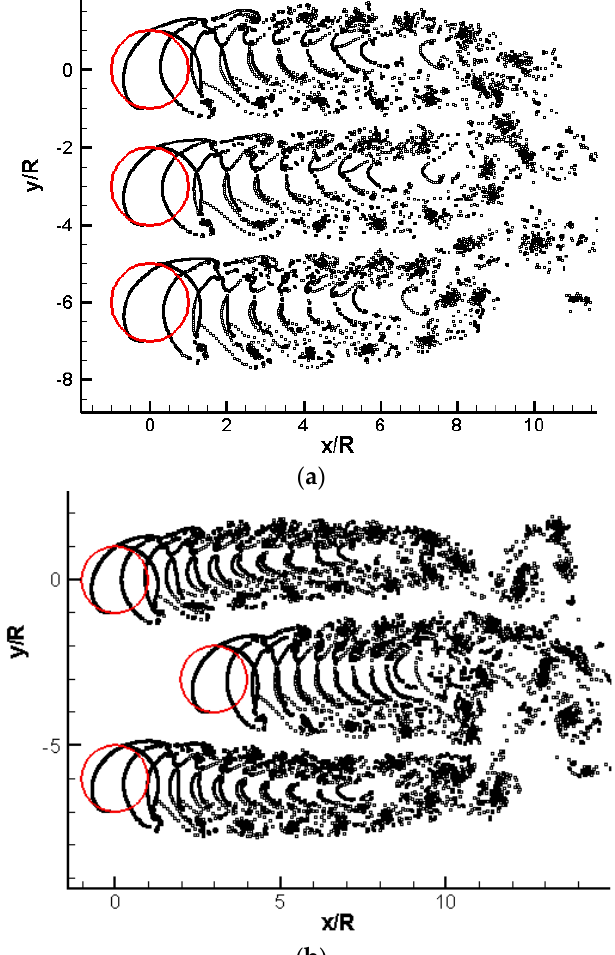
Figure 3. Central path of trailing vortices of turbine array; tip speed ratio λ = 2. The mutual interference of wake of the turbines is shown. ( a ) Three turbines in “-” type arrangement; ( b ) Three turbines in “Z” type arrangement.